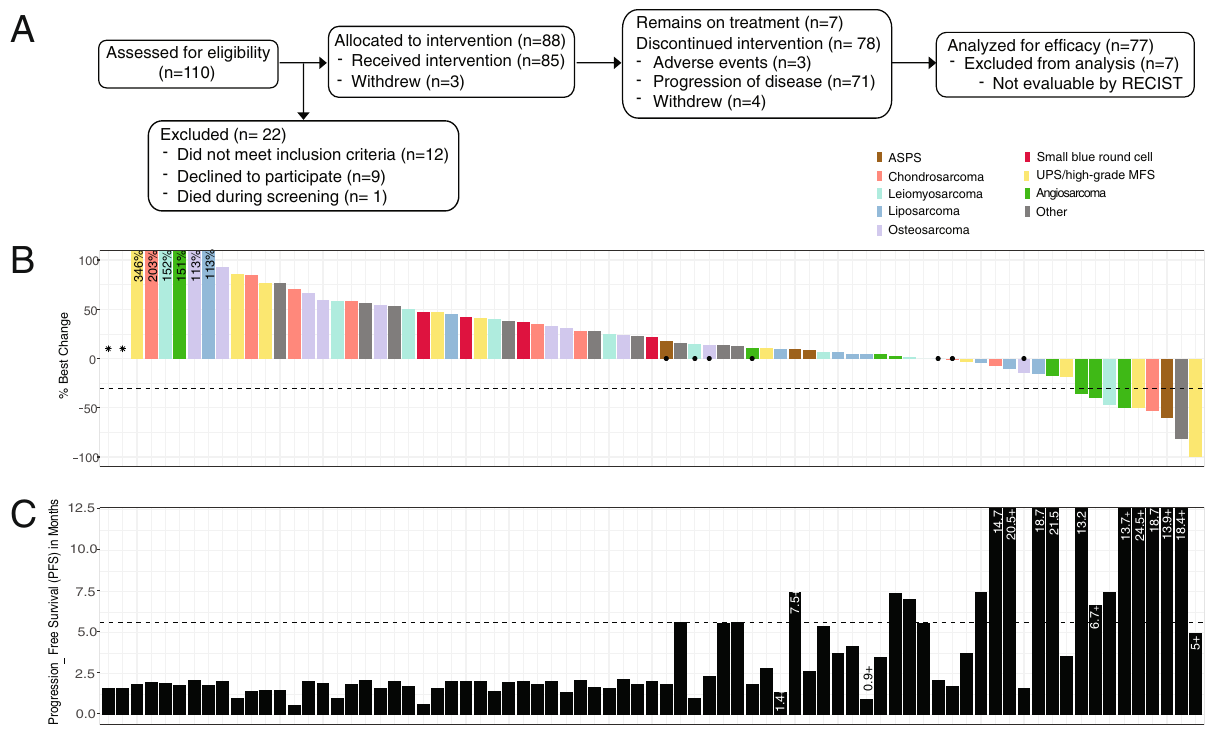
Fig. 1 Response to the combination of nivolumab and bempegaldesleukin in patients with metastatic sarcoma. A CONSORT diagram. B Waterfall plot of overall best response (% change in sum of length measurements) of target lesions/nodes (RECIST v1.1; n = 77 patients evaluable for ef fi cacy). Horizontal line represent cutoff for partial response (PR). Dot indicates achievement of response according to radiographic assessments despite classi fi cation as PD in non-target lesions (per RECIST v1.1). Two patients with progressive disease had target lesions that were not evaluable by RECIST. C Progression-free survival (PFS) for each patient ( n = 77 patients). PFS is listed for patients without progression longer than 1 year and for patients who did not yet reach progression (indicated by + ). Dashed line indicates 24 weeks. ASPS alveolar soft part sarcoma, UPS undifferentiated pleomorphic sarcoma, MFS myxo fi brosarcoma. Source data are provided as a Source Data fi